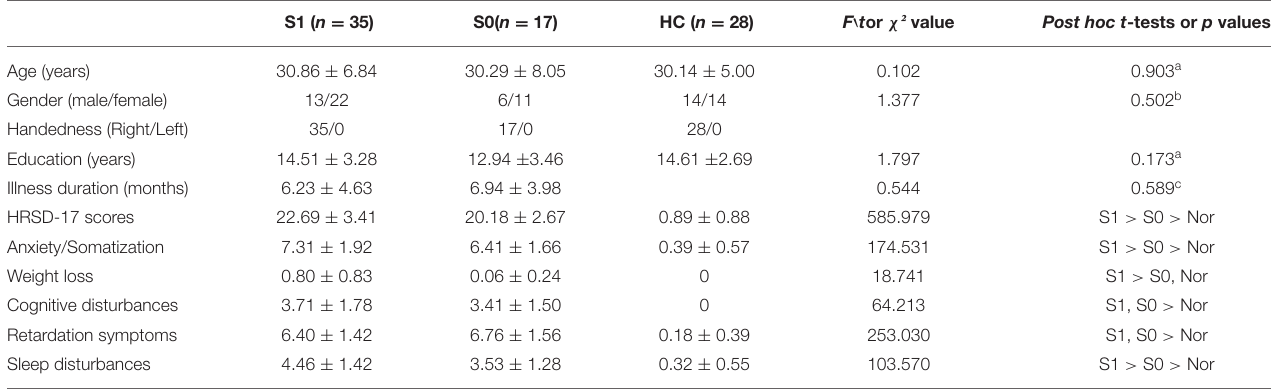
TABLE 1 | Demographic and clinical characteristics of the participants.